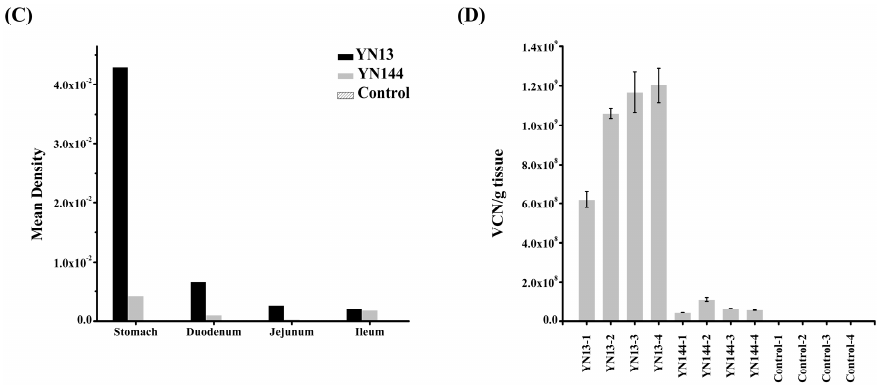
Figure 1. Comparison of YN13 and YN144 infection in target tissues. ( A ) Histopathological analysis of the YN13-infected, YN144-infected, and control groups ( B ) Immunohistochemical assay of the YN13-infected, YN144-infected, and control groups; ( C ) Mean density of porcine epidemic diarrhea virus (PEDV) in each tissue shown in (B); ( D ) The viral load in jejunum sample of each piglet was quantified using real-time RT-PCR. The average viral copy number (VCN) per g tissue of each piglet was calculated. Error bars indicate standard error from the mean, and the horizontal axis indicates the number of piglets.